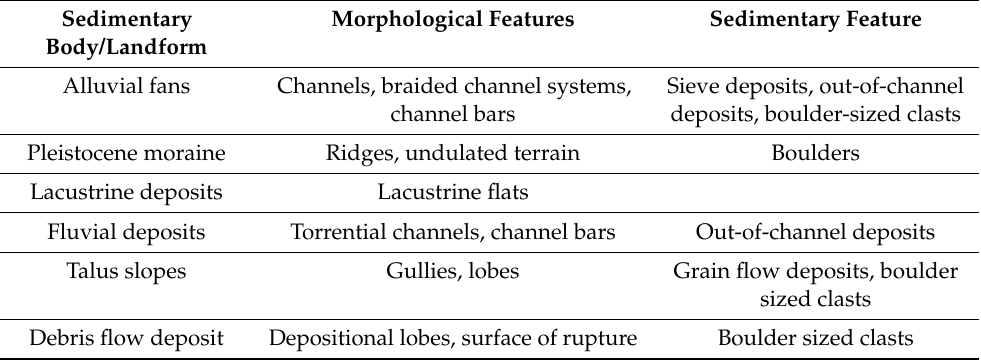
Table 2. Distinctive morphological and sedimentary features of investigated sedimentary